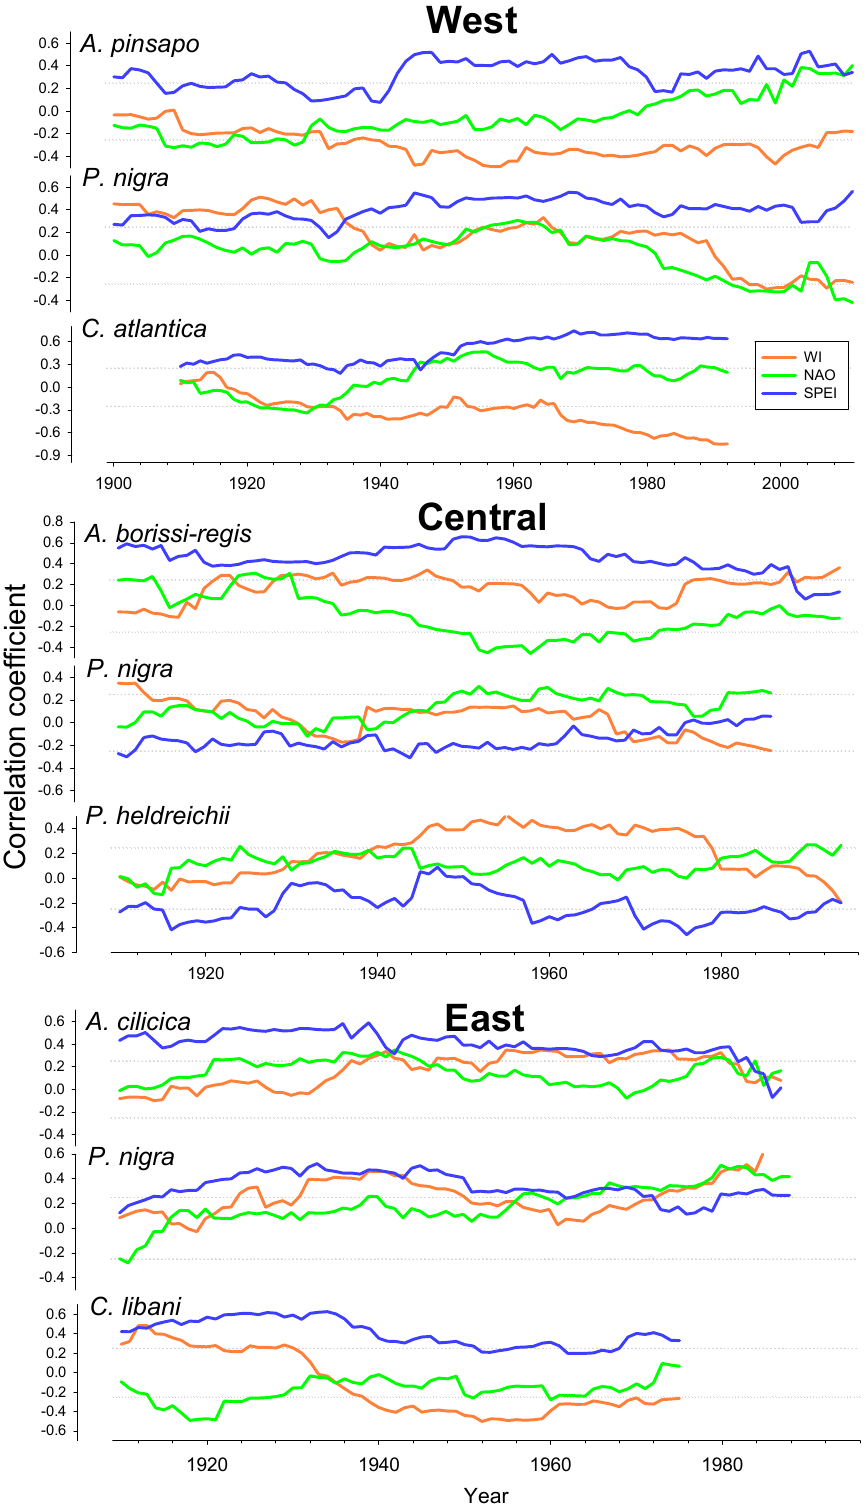
Figure 7. Temporal changes in bootstrapped correlation coe ffi cients between tree-ring width indices (TRWi) and the best correlated (see Figure 6) SPEI, NAO, and WI using 30-year-long intervals shifted by one year for the period of 1903–2001 (values are arranged for the last year of each 30-year-long interval). Dotted grey horizontal lines indicate statistically significant correlation coe ffi cients ( p < 0.05). Sites’ codes are as in Table 1, and the selected period for each site is shown in Table A1.